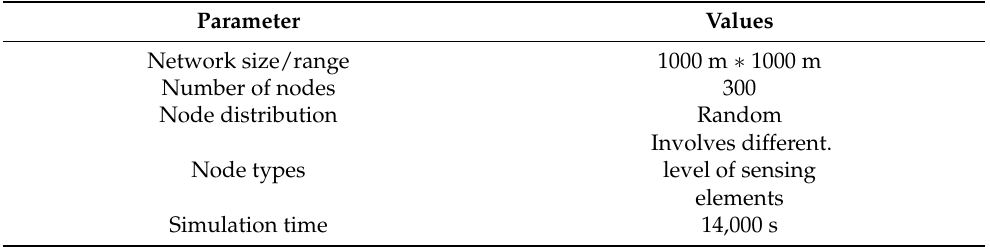
Table 1. Simulation parameters.